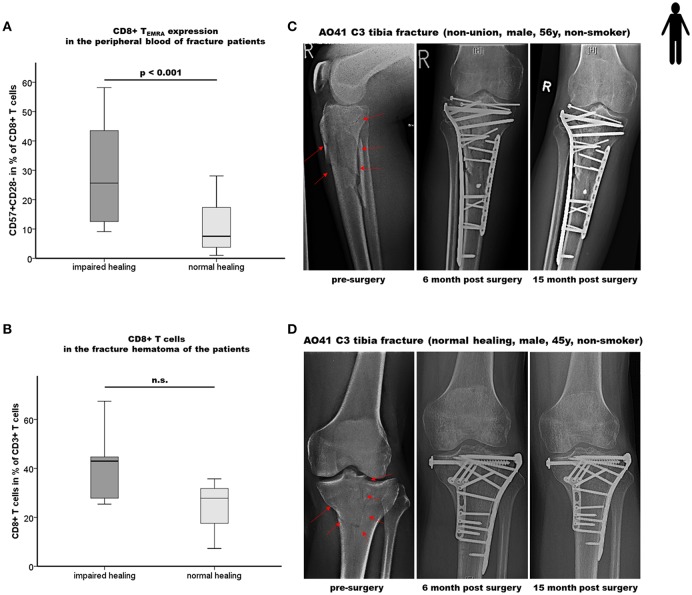
Impaired bone healing correlates with an elevated CD8+ TEMRA level in both the peripheral blood as well as in the local fracture hematoma of patients. (A) Results of the flow cytometry analyses of terminally differentiated CD8+ effector T cells (CD8+TEMRA) in the peripheral blood of fracture patients at the time of operation are shown. Impaired fracture healing patients showed a significantly higher frequency of CD45+CD3+CD8+CD57+CD28- T cells (CD57+CD28-+ in % of CD45+CD3+CD8+ T cells) compared to the normal healing patients indicates a dramatic increase of CD8+ TEMRA: n = 12 for the impaired healing group, n = 23 for the normal healing group. (B) Quantification of CD8+ T cells in the hematoma region of fracture healing patients by epigenetic qPCR analysis. Impaired fracture healing patients showed an elevated level of CD8+ T cells in the local fracture area: n = 5 for the impaired healing group, n = 3 for the normal healing group (C,D) Representative x-ray images from the study cohort over a period of 15 months including the pre-surgery as well as the 6 and 15 months post-surgery states of fracture healing of an impaired healing (C) and a normal healing (D) patient, respectively. Student's t-test.